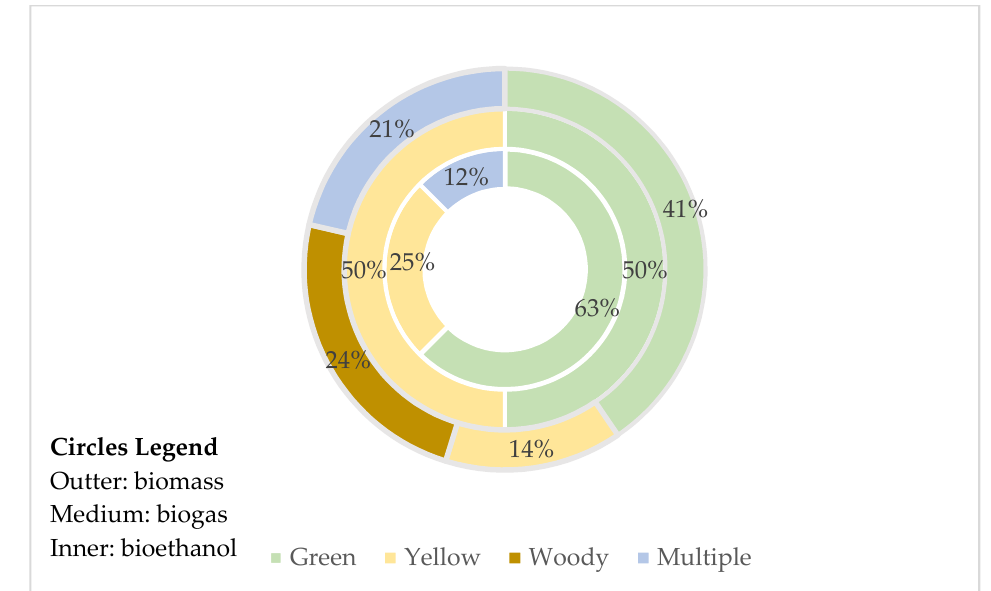
Figure 4. Biomass type in relation to the final product.